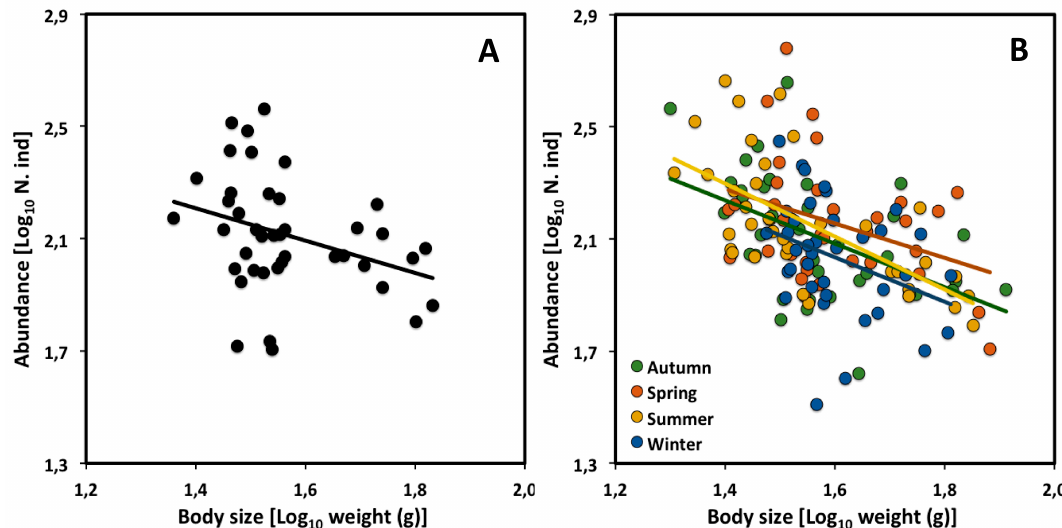
Figure 2. Scaling of density versus mean body size (live weight) of a desert rodent community in Portal